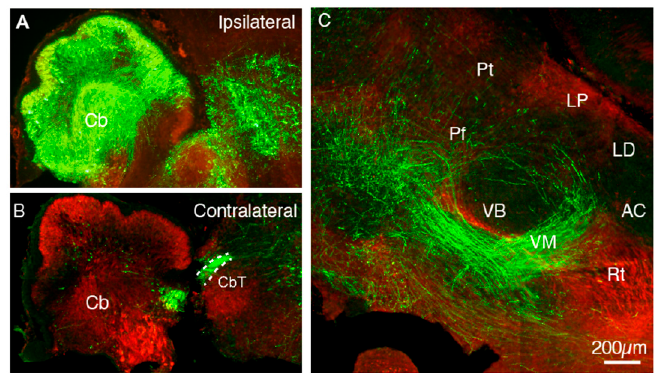
Figure 7. EYFP + fibers of IUE transfected cerebellum are present in the thalamus at E18.5. ( A , B ) EYFP + signal in the transfected ipsilateral cerebellum. ( C ) EYFP + fibers in the thalamic complex show selective innervation of particular nuclei. Note that in this sagittal section several CbT-innervated nuclei are outside the field of view, i.e., on a different level of the medio-lateral axis. Cb = cerebellum; CbT = cerebellothalamic tract; Pt = pretectum; Pf = parafascicular nucleus; VB = ventrobasal nucleus; VM = ventromedial nucleus; Rt = reticular nucleus; AC = anterior complex; LD = lateral dorsal nucleus; LP = lateral posterior